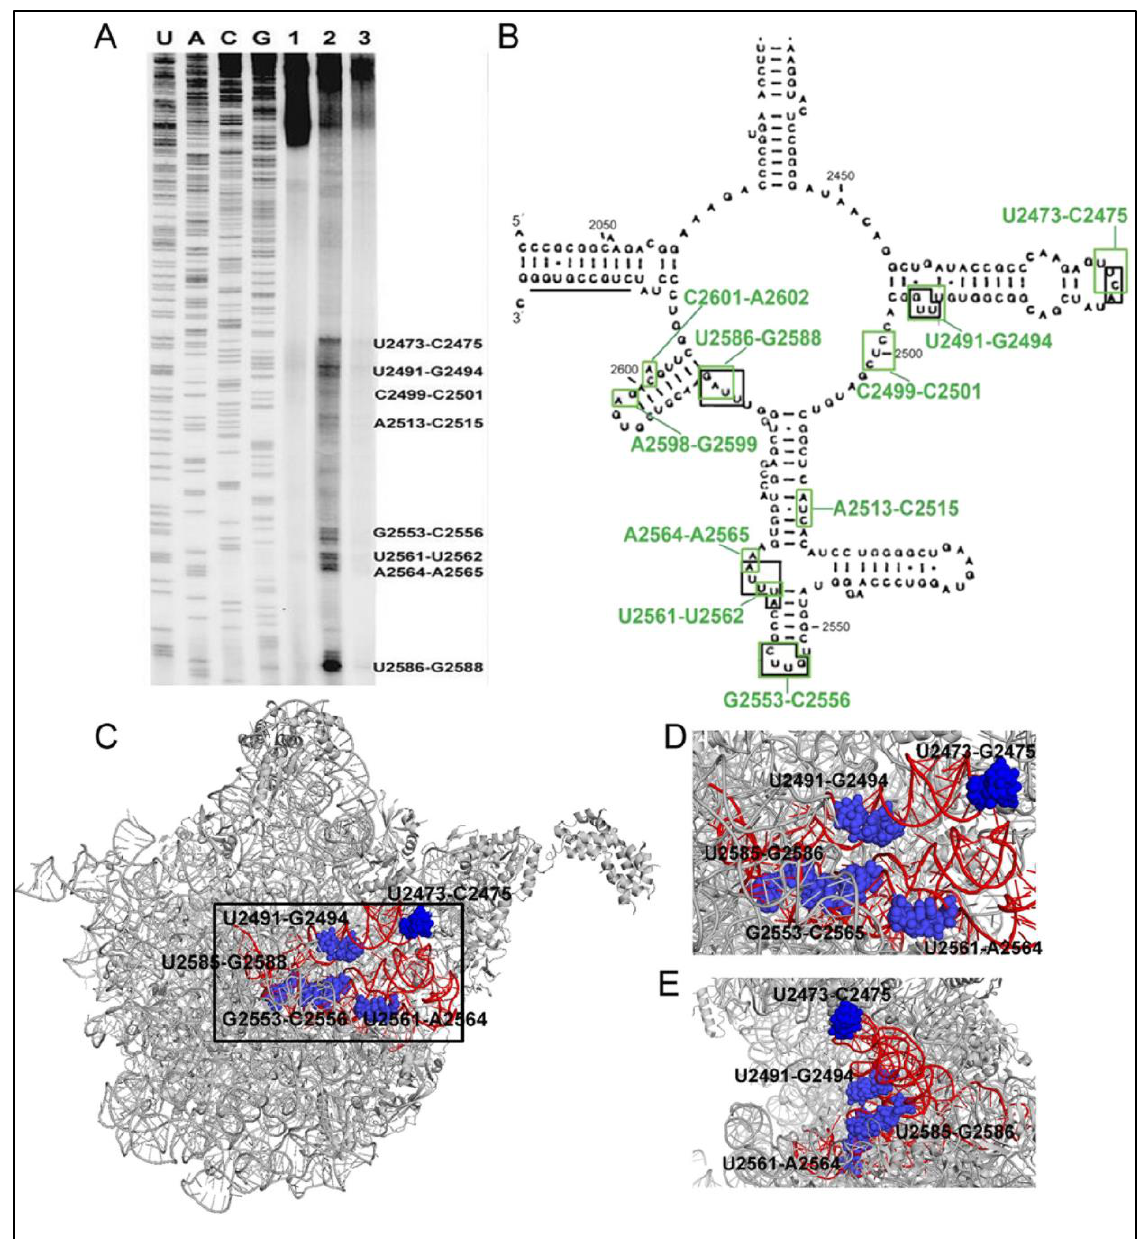
Figure 4. ( A ) Sequencing gel showing the binding (road block) sites of 6AP (lane 2) and 6APi (lane 3) on the domain V rRNA identified by primer extension after UV-crosslinking sites. Lane 1 is the control without 6AP/6APi. ( B ) Binding sites of 6AP and the protein folding substrates in domain V rRNA. The green and the black boxes indicate 6AP and the protein binding sites, respectively. ( A – B ), The research was originally published in JBC [46]; Reproduced with permission. © The American Society for Biochemistry and Molecular Biology); ( C ) The position of the binding sites in the 50S subunit of E. coli ribosome. (PDB ID: 3UOS) The red highlighted portion represents residues 2435–2668 of domain V rRNA where most of the binding sites (marked with blue spheres and labeled with residue numbers) are located; ( D ) and ( E ) The enlarged view of the binding pocket (black box in C ) from front ( D ) and side ( E )